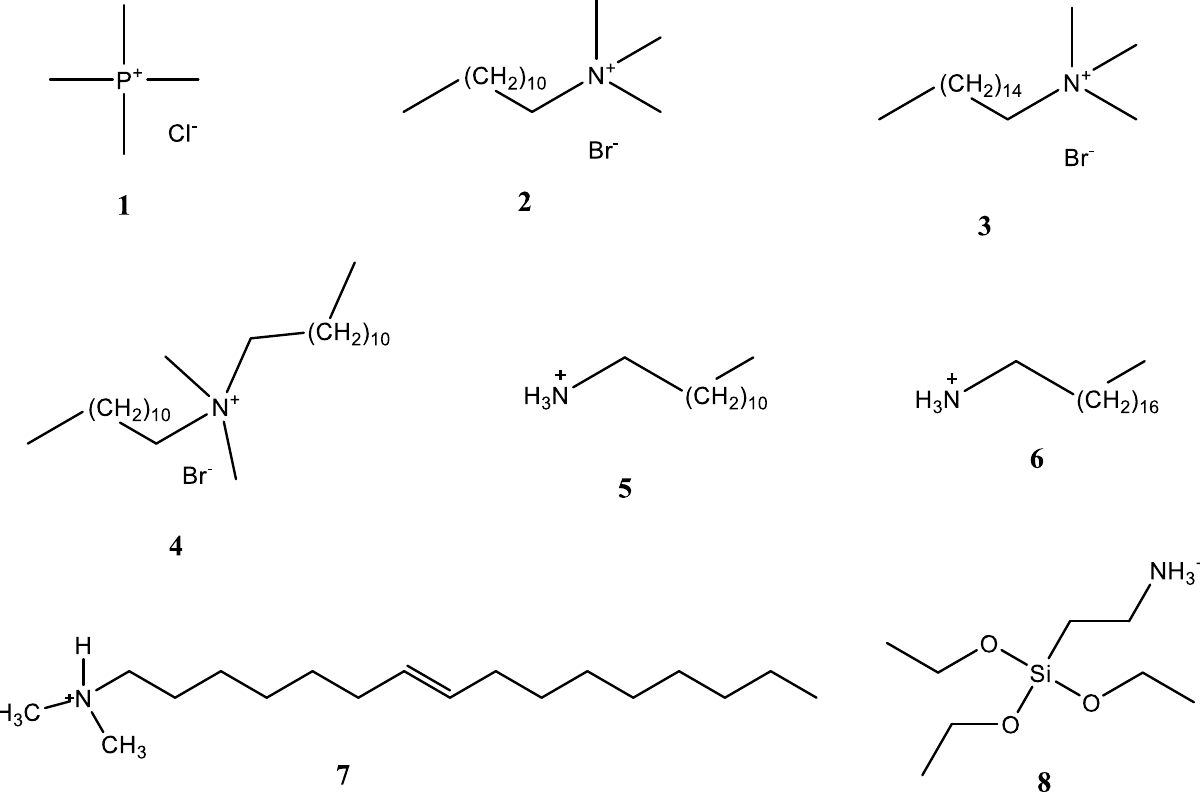
Figure Figure 1. Some examples of organic cations used to produce organoclays: 1 — tetramethyl phosphonium chloride; 2 — do- decyltrimethylammonium bromide (DDTMA), 3 — hexadecyltrimethylammonium bromide (HDTMA), 4 — didodecyltri- methylammonium bromide (DDDTMA), 5 — dodecylamine (DDA), 6 — octadecyl amine (ODA), 7 — C 14 – C 18 unsaturated